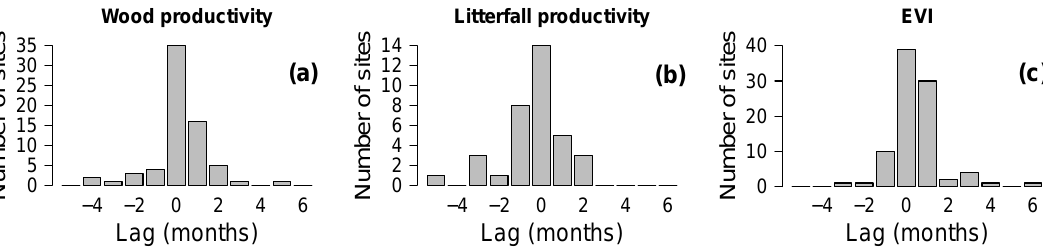
Figure 4. Cross correlation between observations and predictions of wood production (a) , litterfall (b) and EVI (c) with the linear models parameters (Table 4). A cross correlation of zero month indicates a similar seasonal pattern in the time series of observations and predictions.